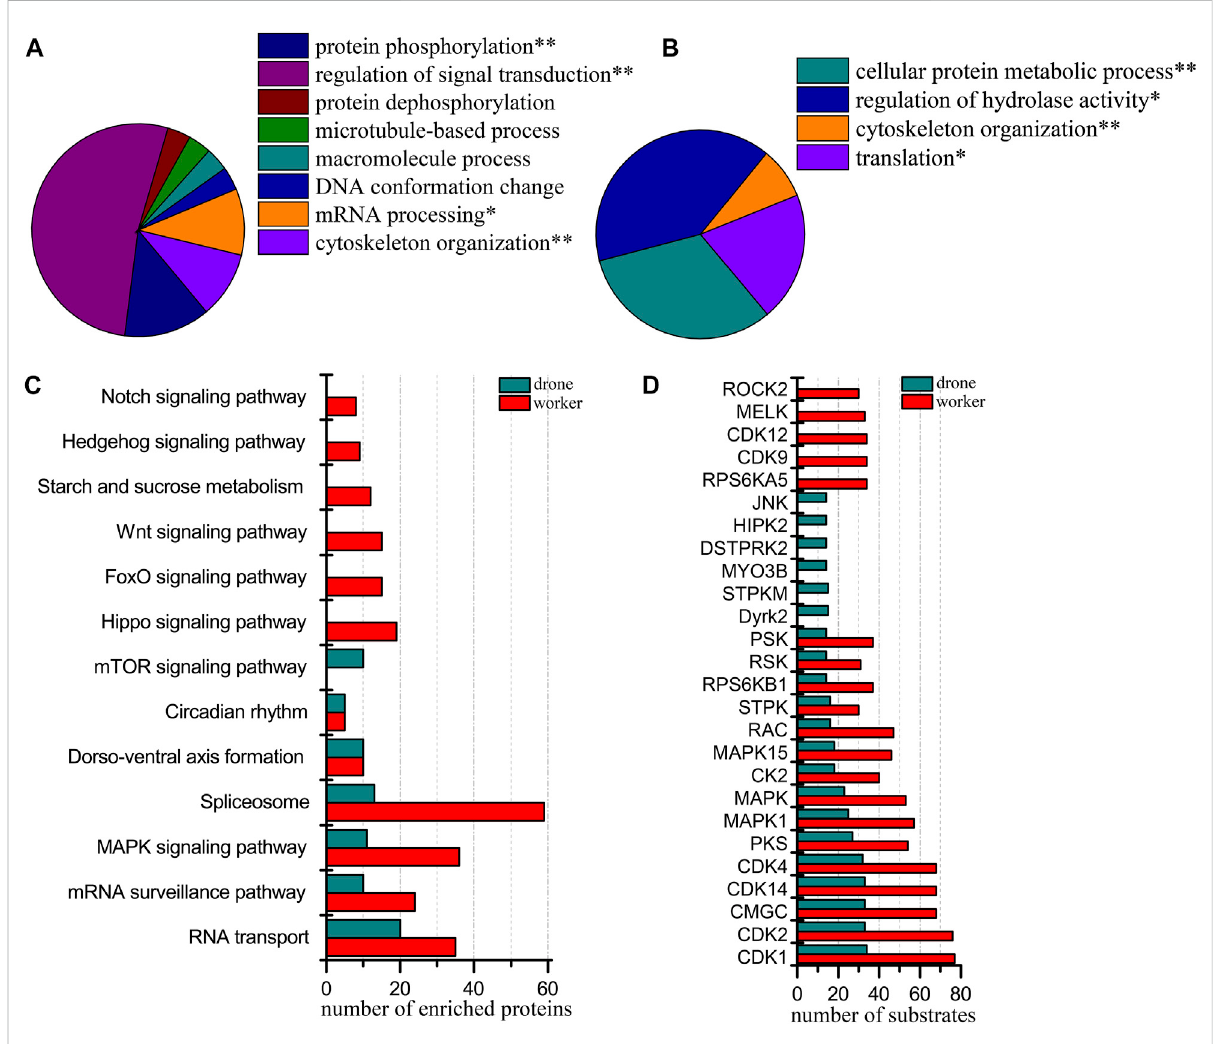
FIGURE 6 Comparison of the phosphoproteins identi fi ed in worker and drone embryos at 72 h. (A) ClueGO analysis of the phosphoproteins identi fi ed in 72 h worker embryos. (B) ClueGO analysis of the phosphoproteins identi fi ed in 72 h drone embryos. (C) Comparison of the biological pathways enriched in worker and drone embryo at 72 h. (D) Comparison of the kinase activity between the embryogenesis of worker and drone at 72